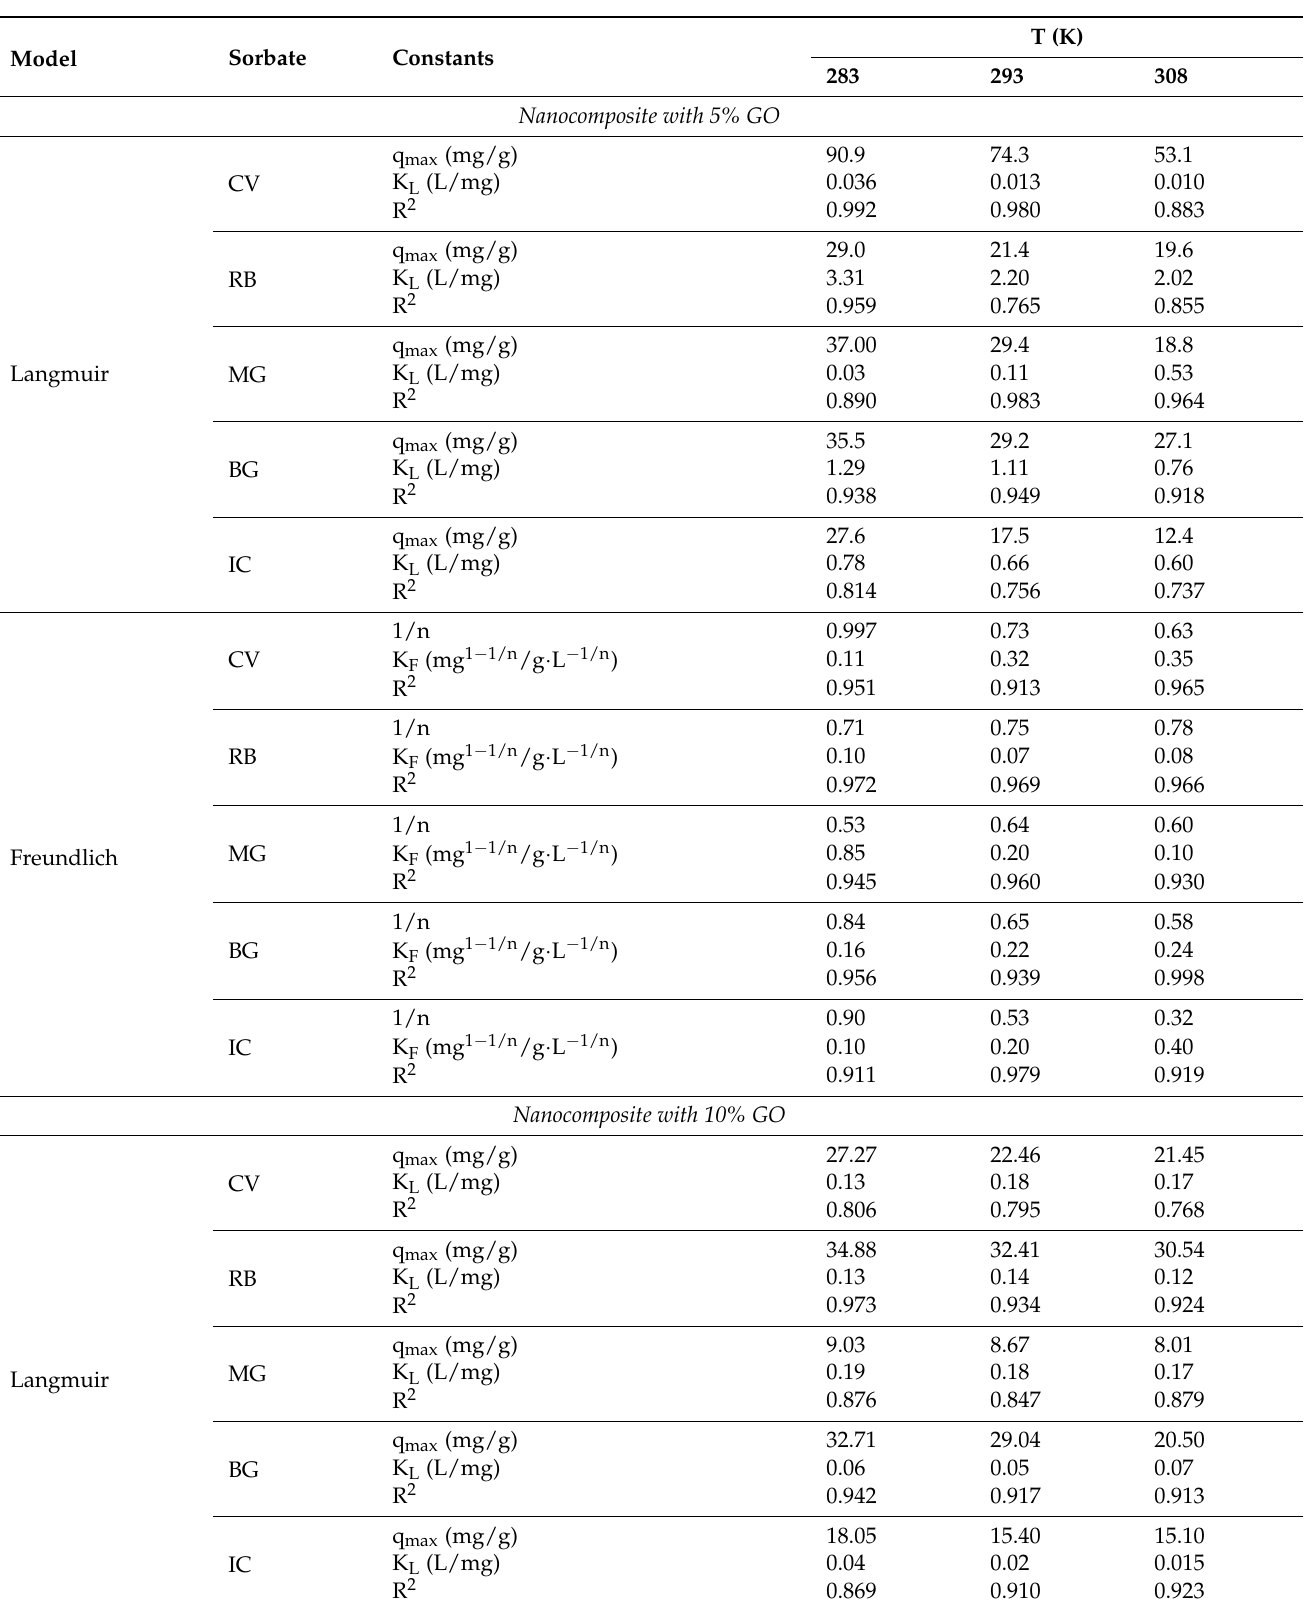
Table 3. Isotherm model constants of dyes by the